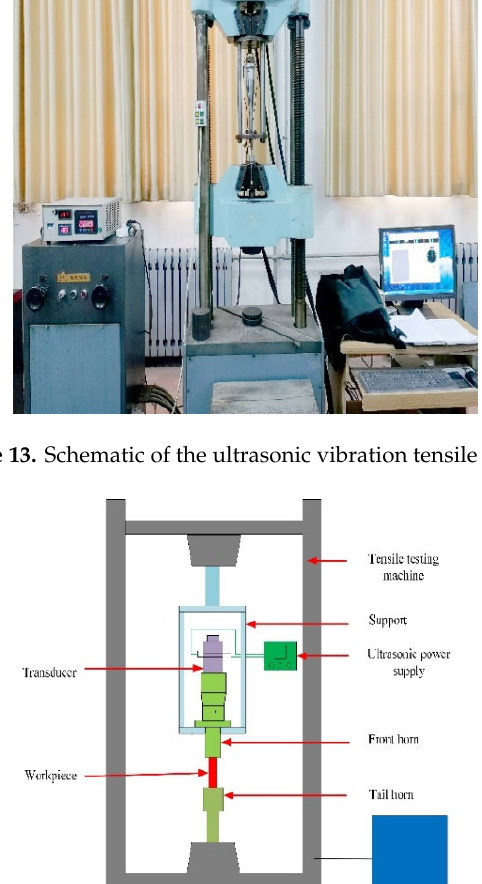
Table 8. The tensile experimental design.